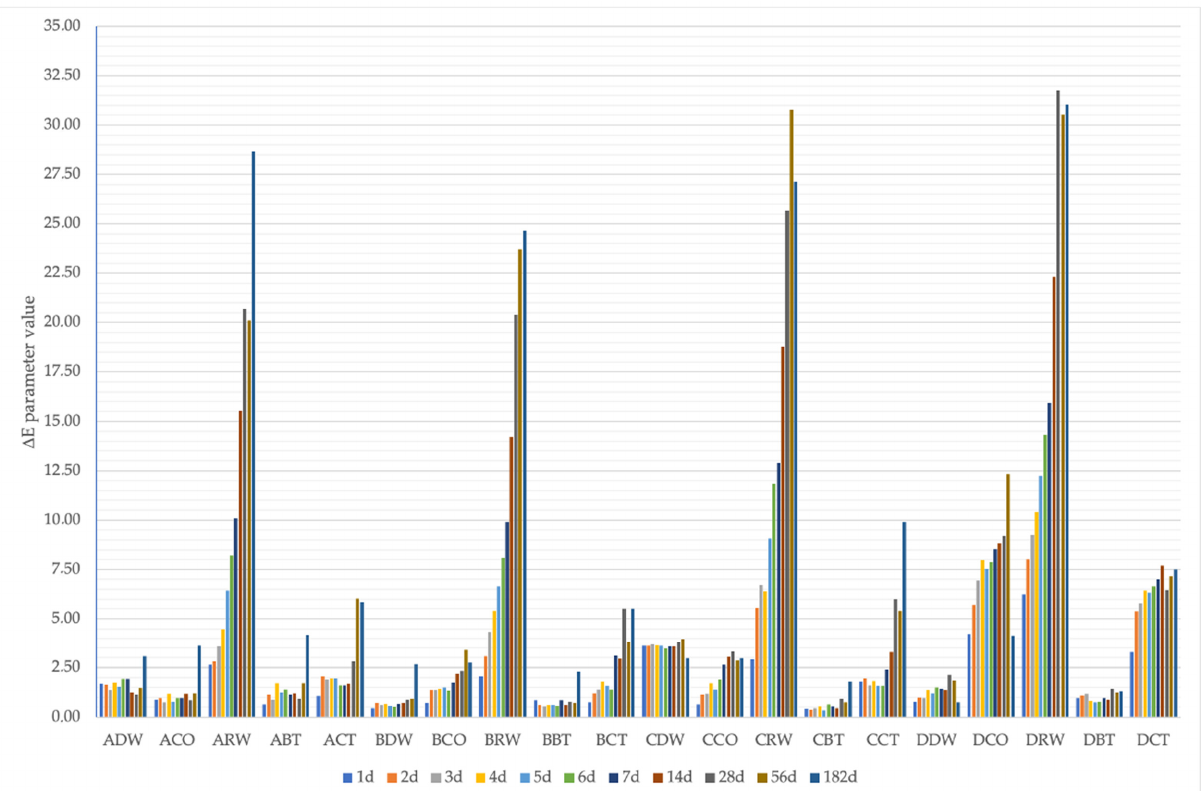
Figure 2. Comparison of mean values of ∆ E parameter according to subgroup (immersion solution) and time.